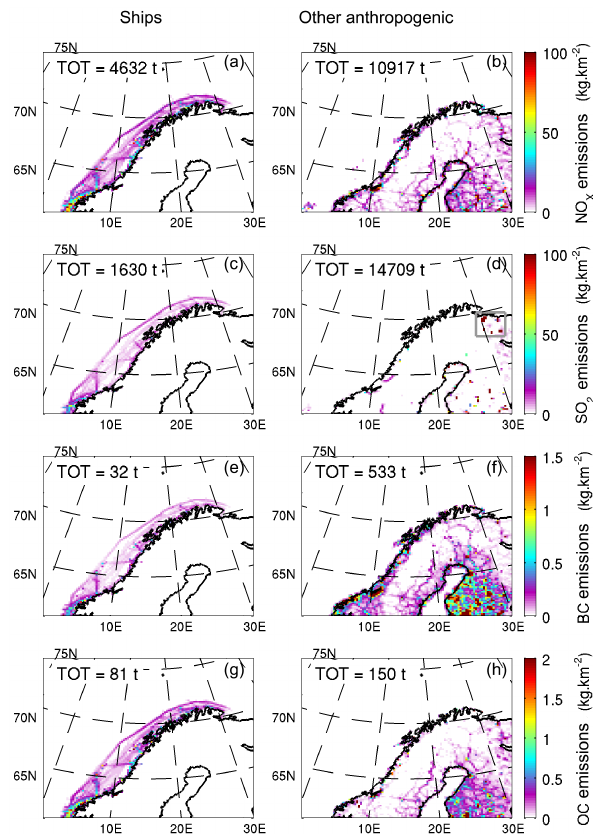
Figure 2. (a, c, e, g) STEAM2 ship emissions and (b, d, f, h) HTAPv2 anthropogenic emissions (without ships) of (a, b) NO x , (c, d) SO 2 , (e, f) BC, and (g, h) OC in kgkm − 2 over the CTRL and NOSHIPS WRF-Chem domain, during the simulation period (00:00UTC 4 July 2012 to 00:00UTC 26 July 2012). On panel (d) , the location of the intense Kola Peninsula SO 2 emissions is high- lighted by a gray box. The emissions totals for the simulation period are noted in each